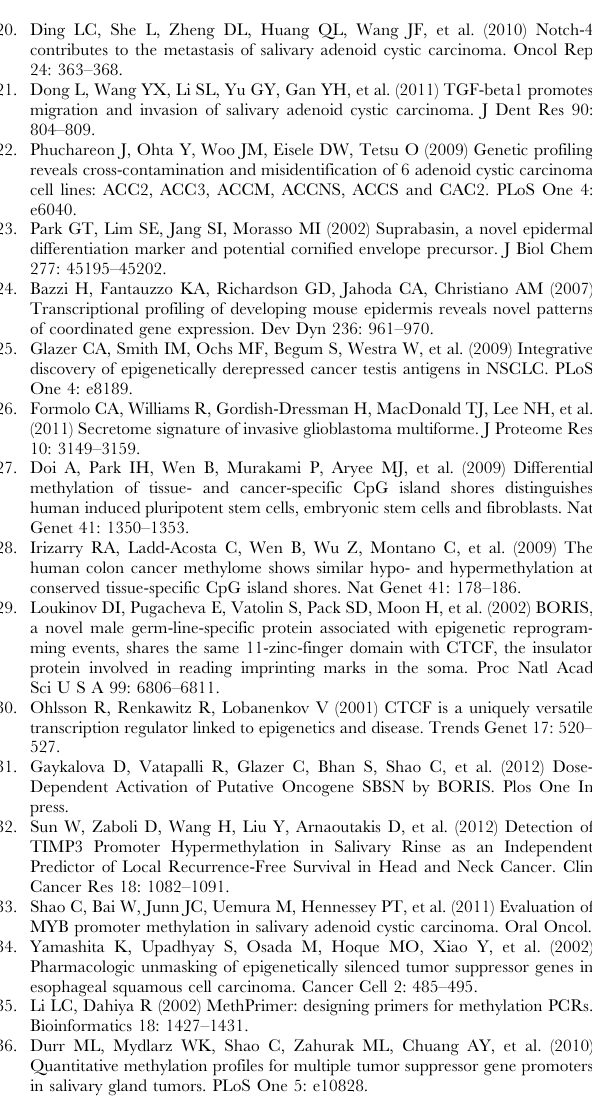
Table S1 Clinical and outcome measures of patients with high and low SBSN methylation